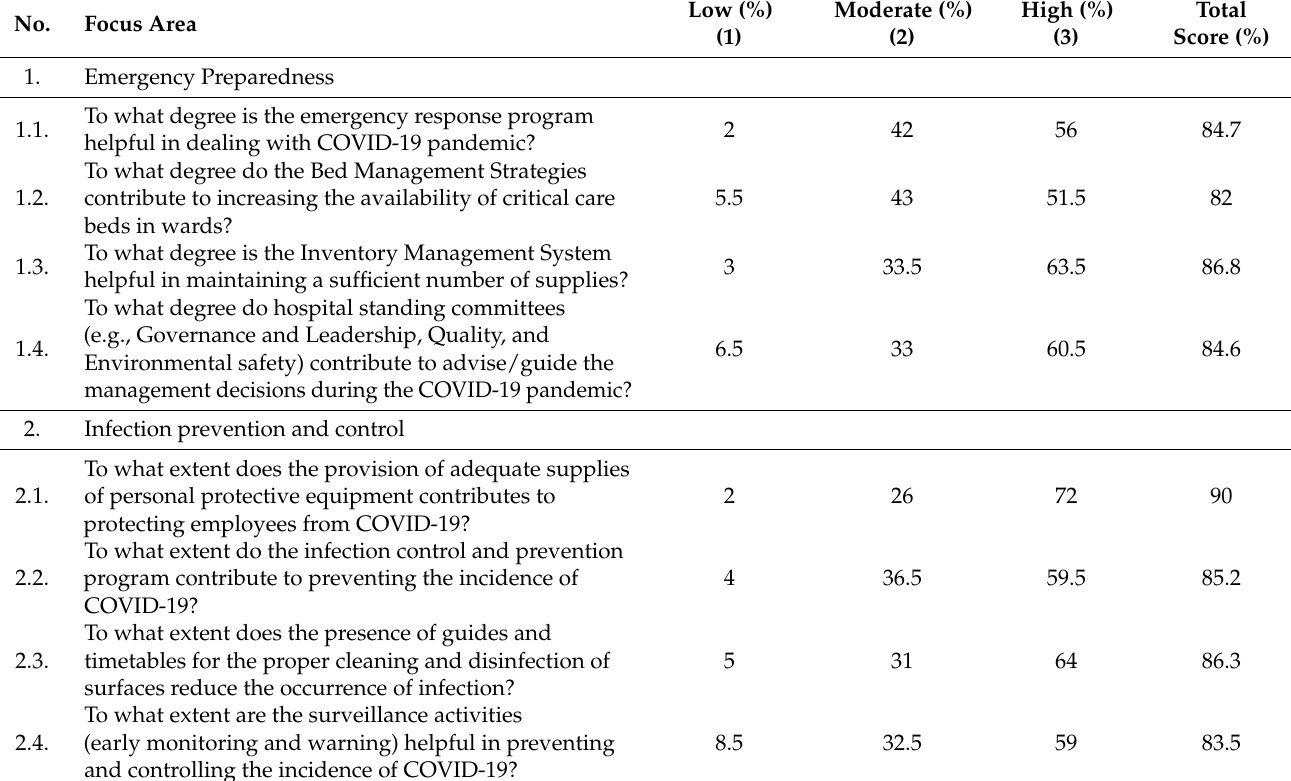
Table 3. Participants’ responses regarding the patient safety focus